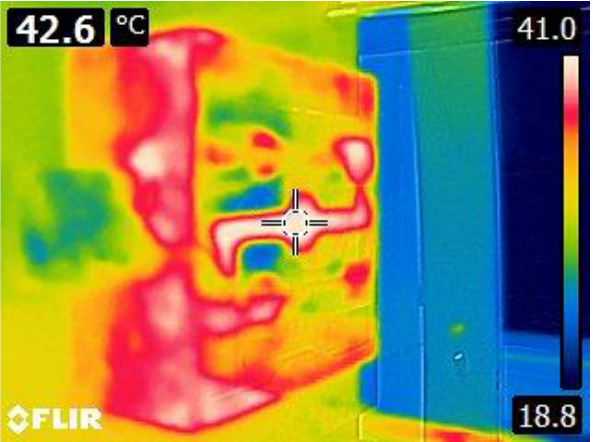
Figure 2. Temperature profile of the steel mould after 23 shots.